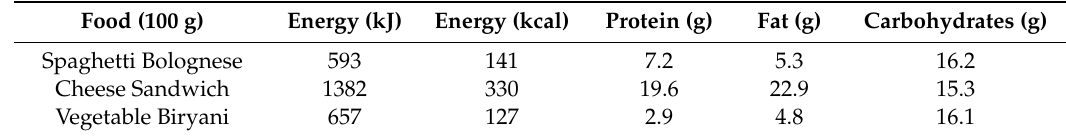
Table 1. Energy density and macronutrient content for 100 g portions of each of the three